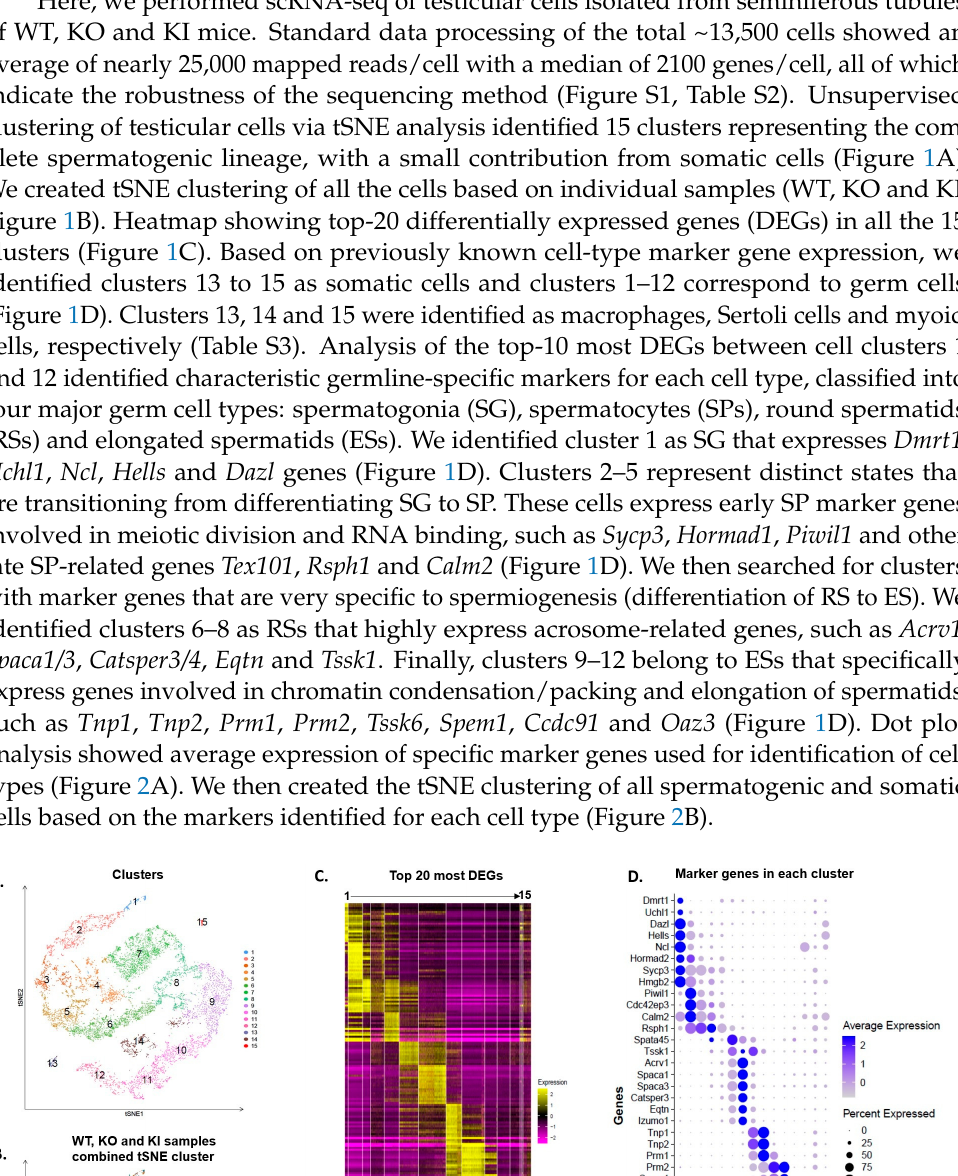
Figure 2. ( A ) Dot plot analysis of characteristic marker genes in different stages of germ cell development during spermatogenesis. ( B ) tSNE representation of spermatogenic and somatic cell- type clusters based on the marker genes identified. 2.2. Pseudotime Trajectory Analysis of Germ Cell Development during Spermatogenesis For further downstream analysis, somatic cell clusters were excluded from gene expression analysis, and we focused on germ cell clusters 1–12. We clustered only the germ cells from WT, KO and KI samples undergoing different stages of spermatogenic development into four major cell types (Figure 3A). We performed pseudotime analysis on these major germ cell clusters, which revealed a long, continuous trajectory of germ cell development, sometimes separated by distinct states, indicating temporal order of spermatogenesis in the WT sample (Figure 3B). However, in the case of KO and KI samples, this continuous trajectory of germ cell development is halted in the RS stage, where RSs fail to elongate completely, with no distinct ES (Figure 3B).